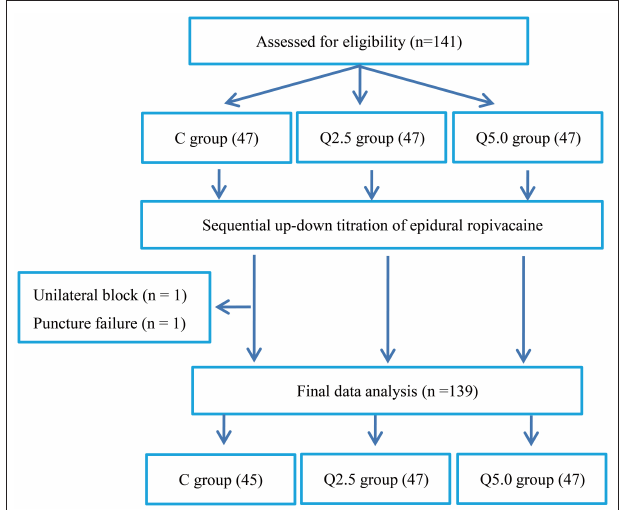
FIGURE 1 | Flow diagram of the